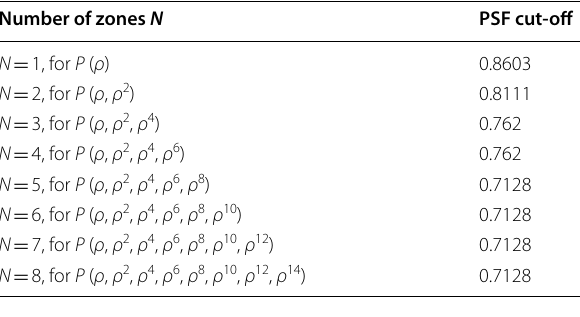
Table 1 Influence of the number of zones N upon the PSF for